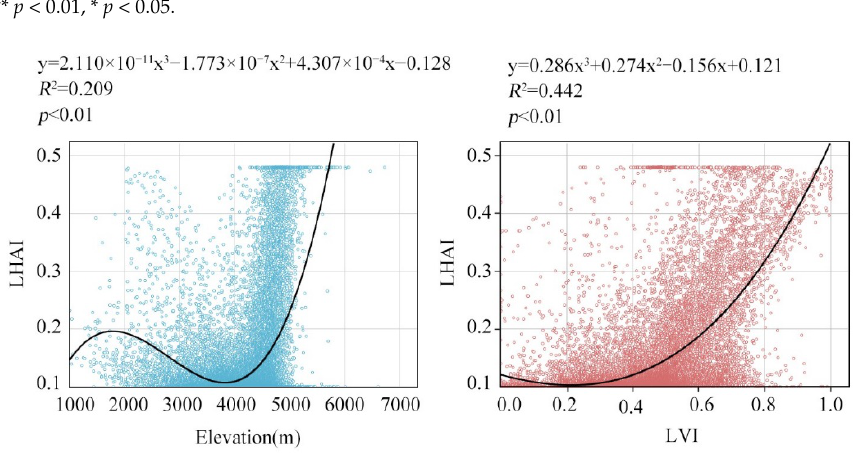
Figure 7. Relationship between LHAI, LVI and elevation in the study area.